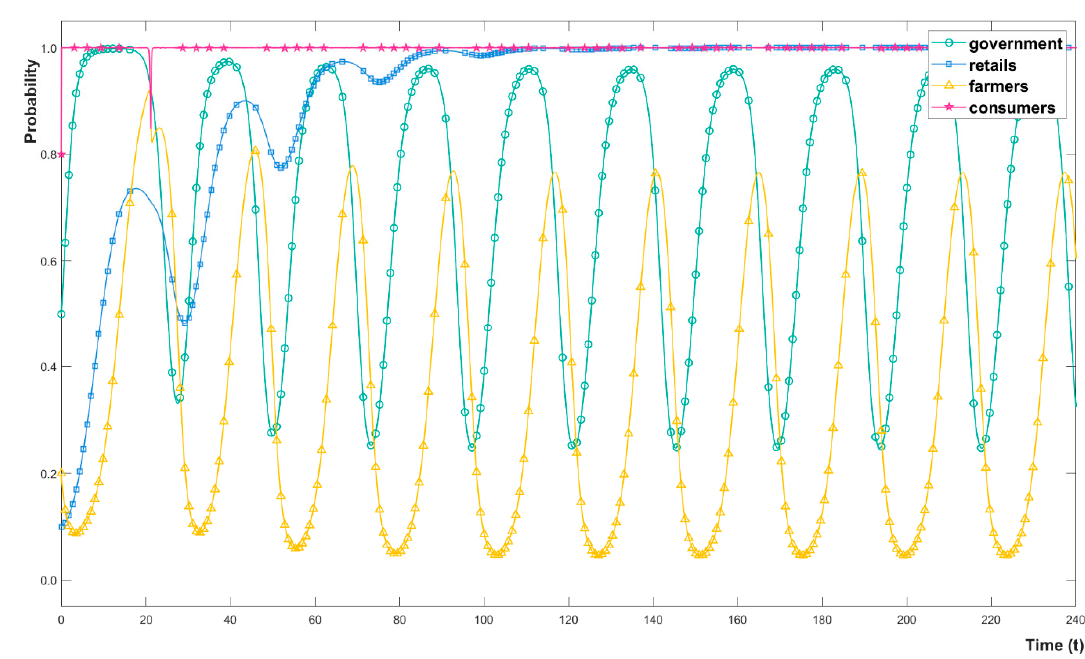
Figure 3. The evolutionary process of stakeholders’ probability of strategy choice.